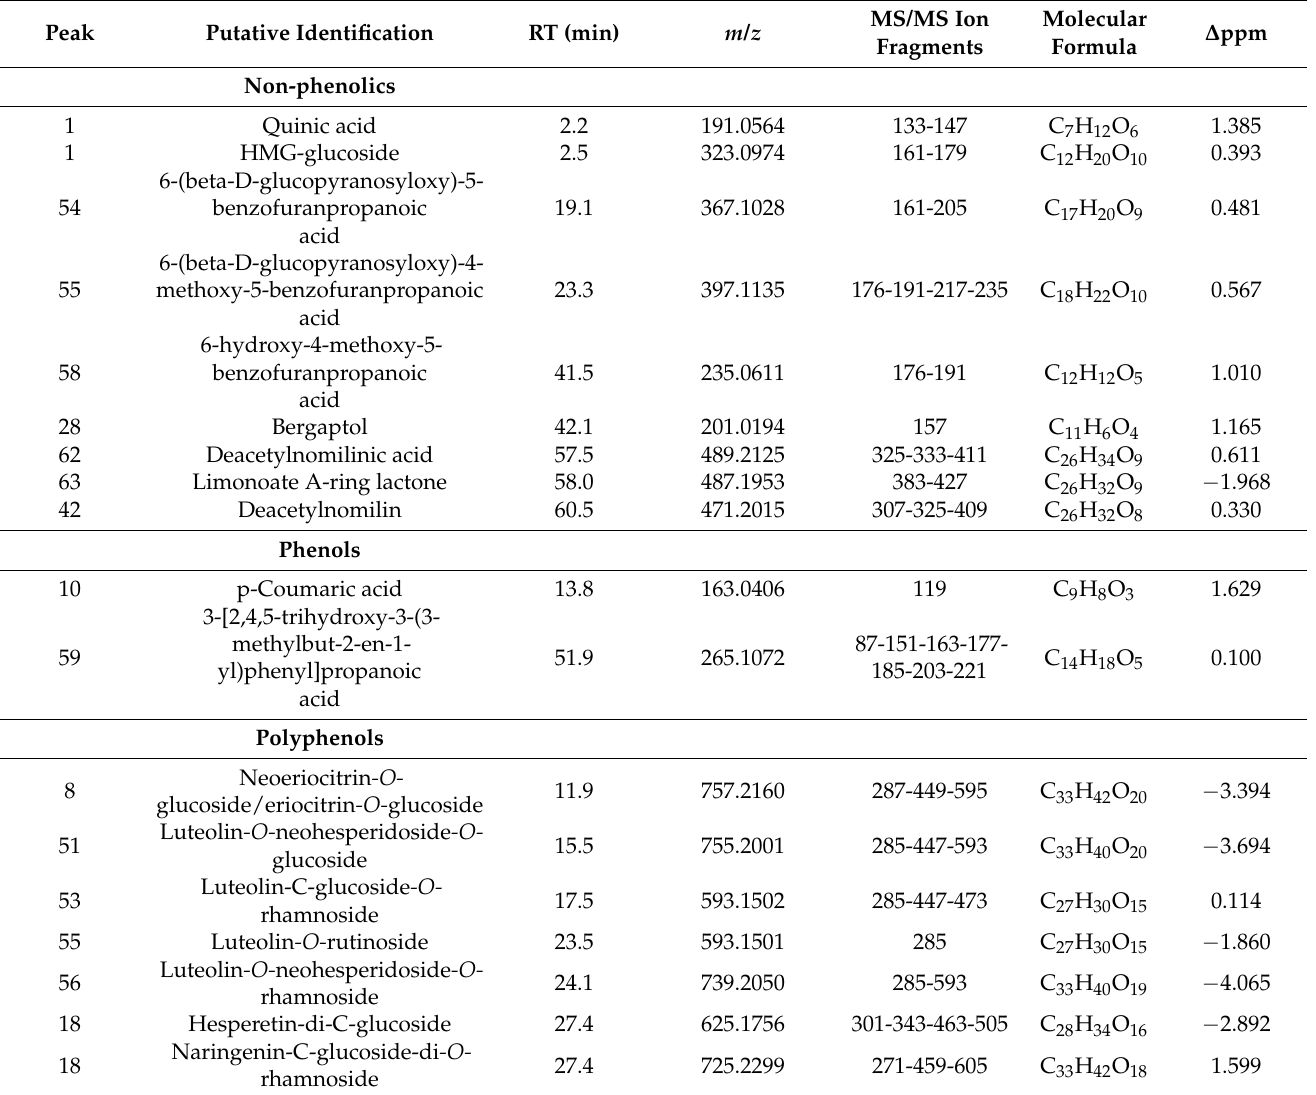
Table 3. Compounds putatively identified with the untargeted